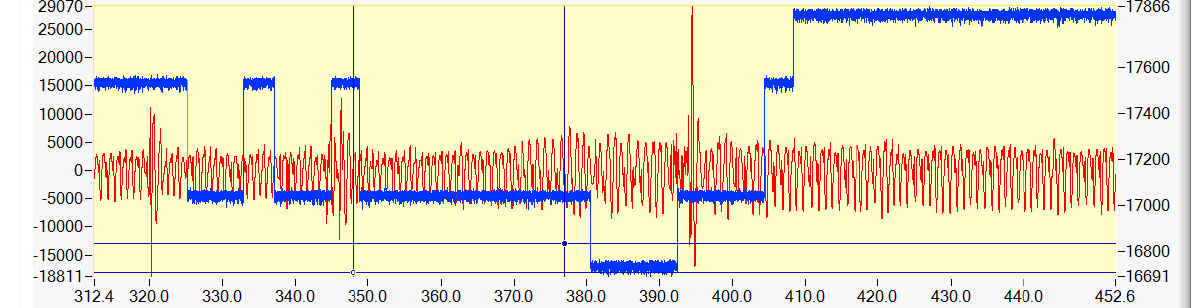
Fig. 2. Breath holding . REG (red) and NIRS (blue) signals during breath holding (see 350-380 seconds: breath holding is indicated by light blue vertical lines). REG and NIRS amplitude increases were simu1taneous: 20.2 % of baseline (after test). (Y-axis values are shown in AD conversion units; X-axis values are shown in seconds).